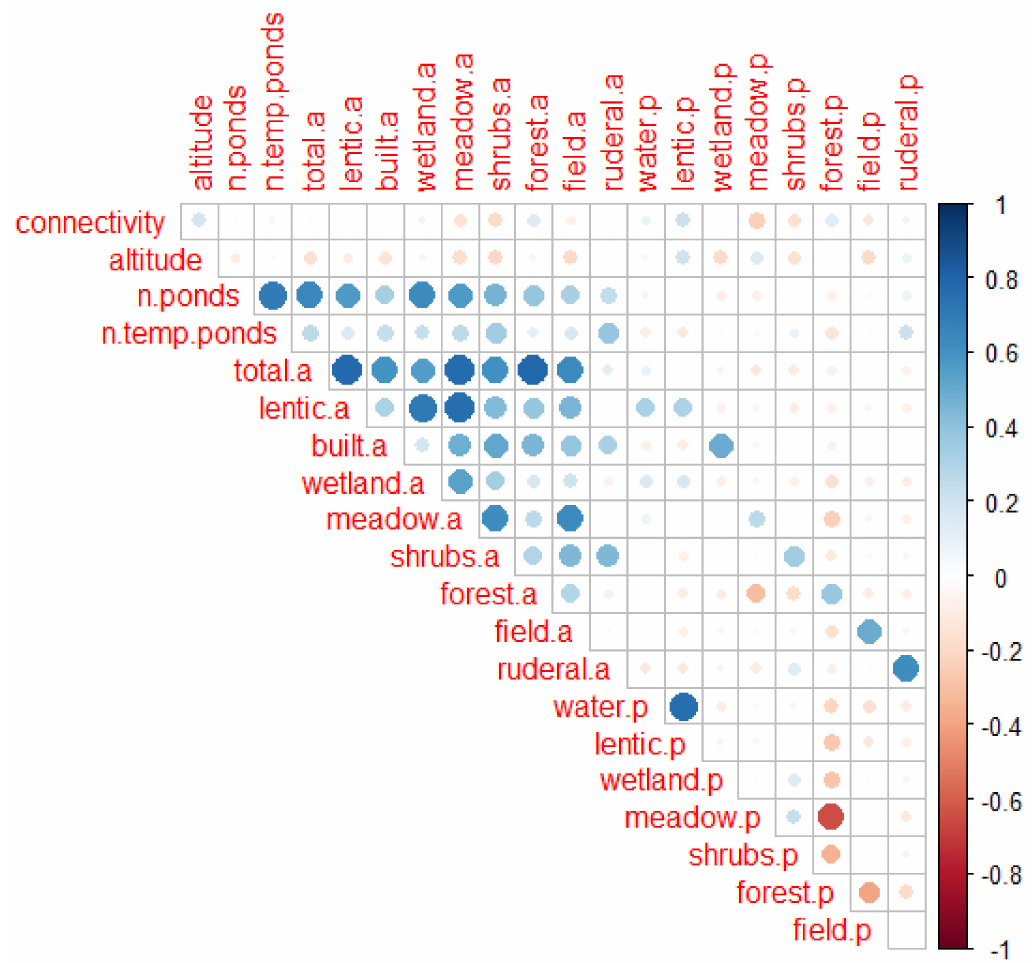
Figure A2. Results of the correlation analysis. See text for further